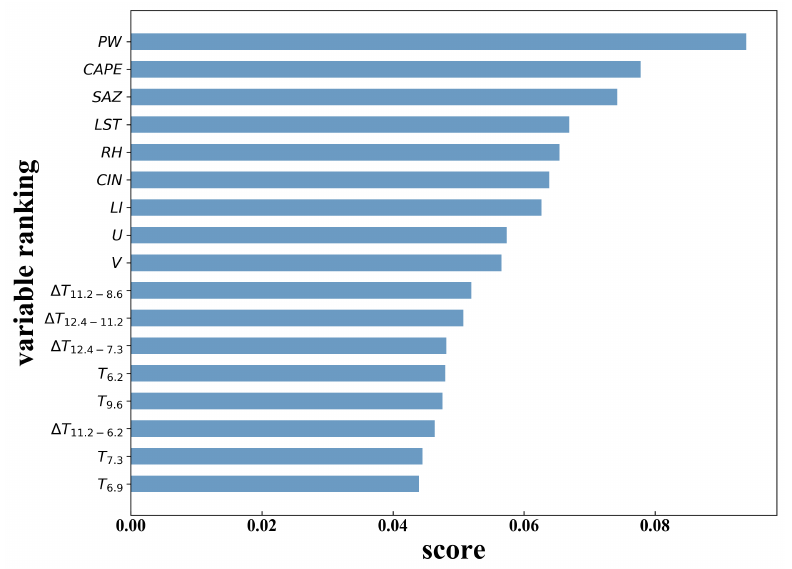
Figure 10. The ranking of the predictor variable in the RF model for the precipitation grades’ estimation.